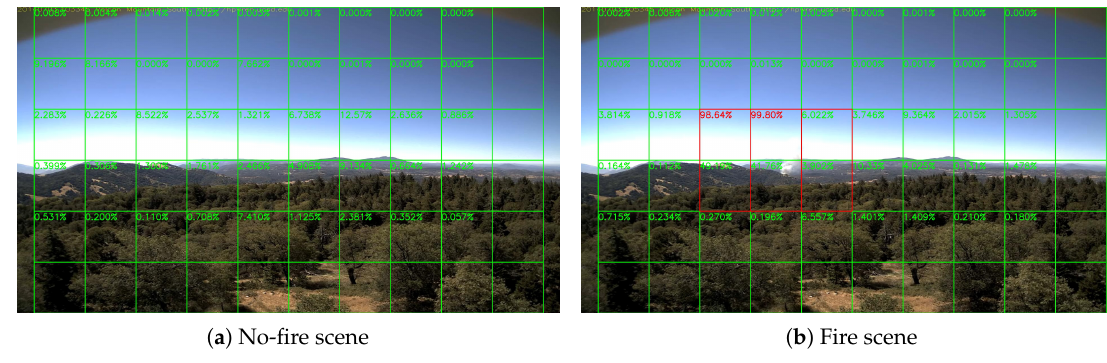
Figure 10. Banner fire, 3 June 2014.